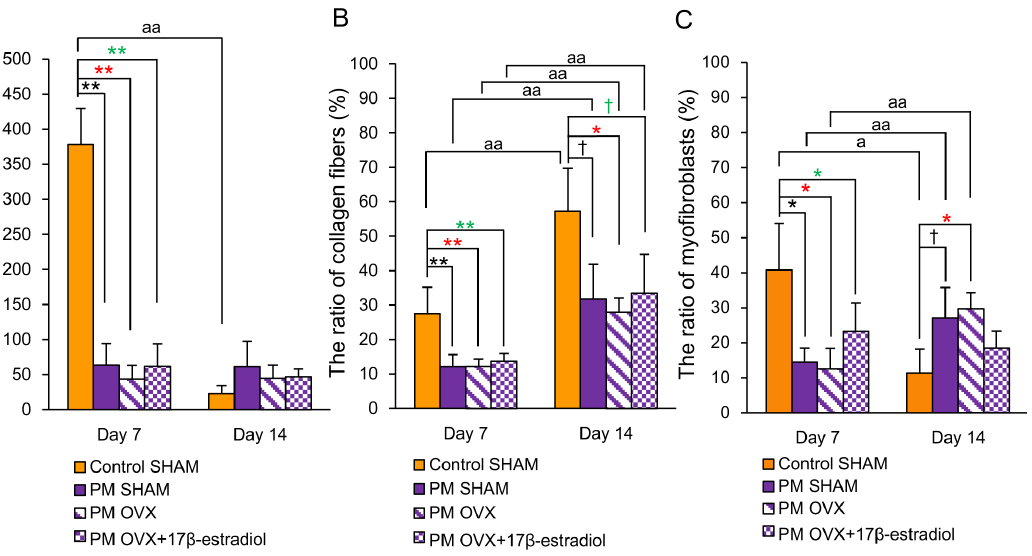
Fig. 6. New blood vessels, collagen fibers and wound contraction. (A) The number of new blood vessels per mm 2 , (B) the ratio of collagen fibers (%) and (C) the ratio of myofibroblasts (%) are shown on box graphs. Values are expressed as mean ¡ SD, n 5 3–5 for each group, ANOVA, Tukey-Kramer { p , 0.1, * p , 0.05, ** p , 0.01 (in black): Control SHAM versus PM SHAM, * p , 0.05, ** p , 0.01 (in red): Control SHAM versus PM OVX, { p , 0.1, * p , 0.05, ** p , 0.01 (in green): Control SHAM versus PM OVX + 17 b -estradiol, and t-test a p , 0.05, aa p , 0.01: day 7 versus day